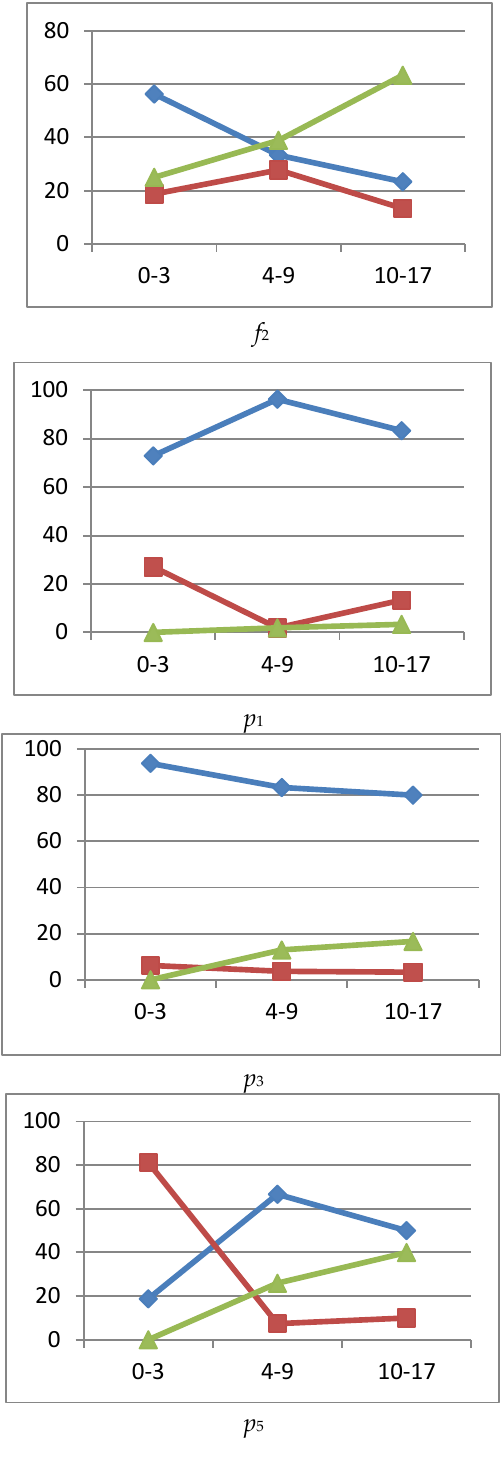
Int. J. Environ. Res. Public Health 2022 , 19 , x 9 of 18